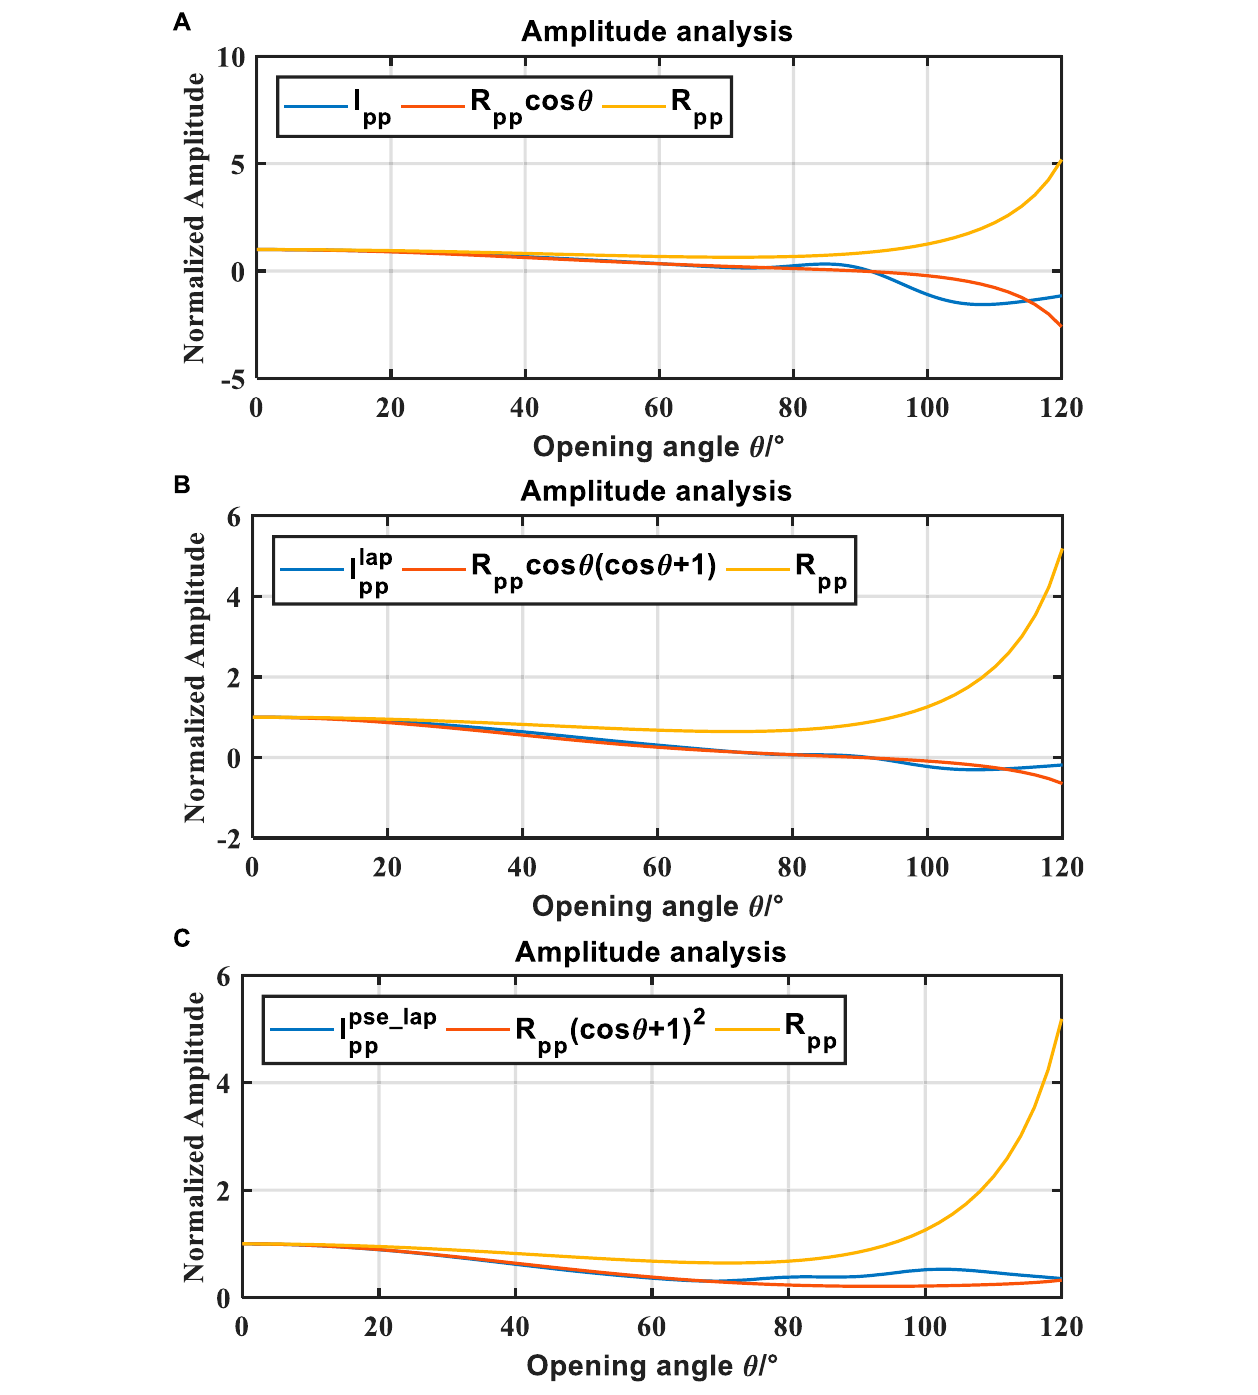
FIGURE 10 | The comparison between the analytical re fl ection coef fi cient R pp (yellow curves), the weighting theoretical re fl ection coef fi cient (red curves) and normalized amplitudes (blue curves) extracted from PP images by the scalar imaging condition (A) , the scalar imaging condition with a Laplace fi lter (B) , and the scalar imagingcondition withapseudo-Laplace fi lter (C) in Figure 9 . There fl ection coef fi cient (yellow curves) issolved bytheZoeppritz equation withtheelasticparameters of the two-layer layer model, and the normalized amplitudes in PP images have been converted to variation with the opening angle.